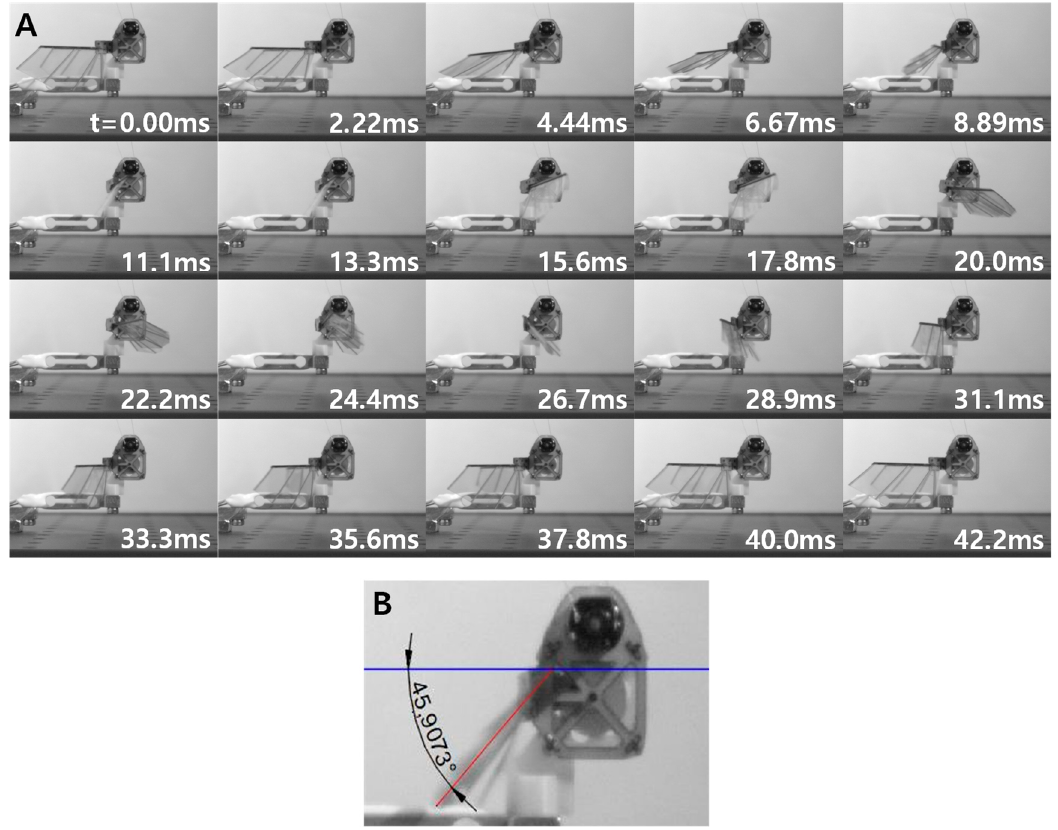
Figure 9. ( A ) Side view of the flapping mechanism at 23 Hz, taken at 900 fps. ( B ) Wing rotation angle can be measured.